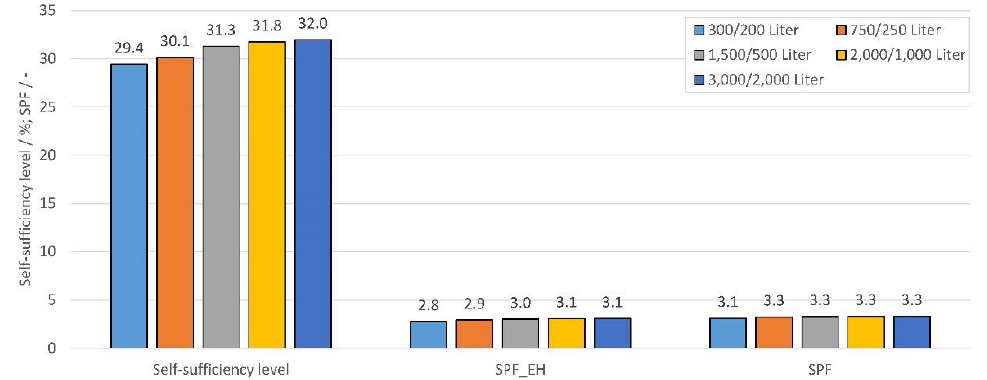
Figure 4. Results of the TES volume variation for multi-family house (MFH) category 1 reference building for year 2020.